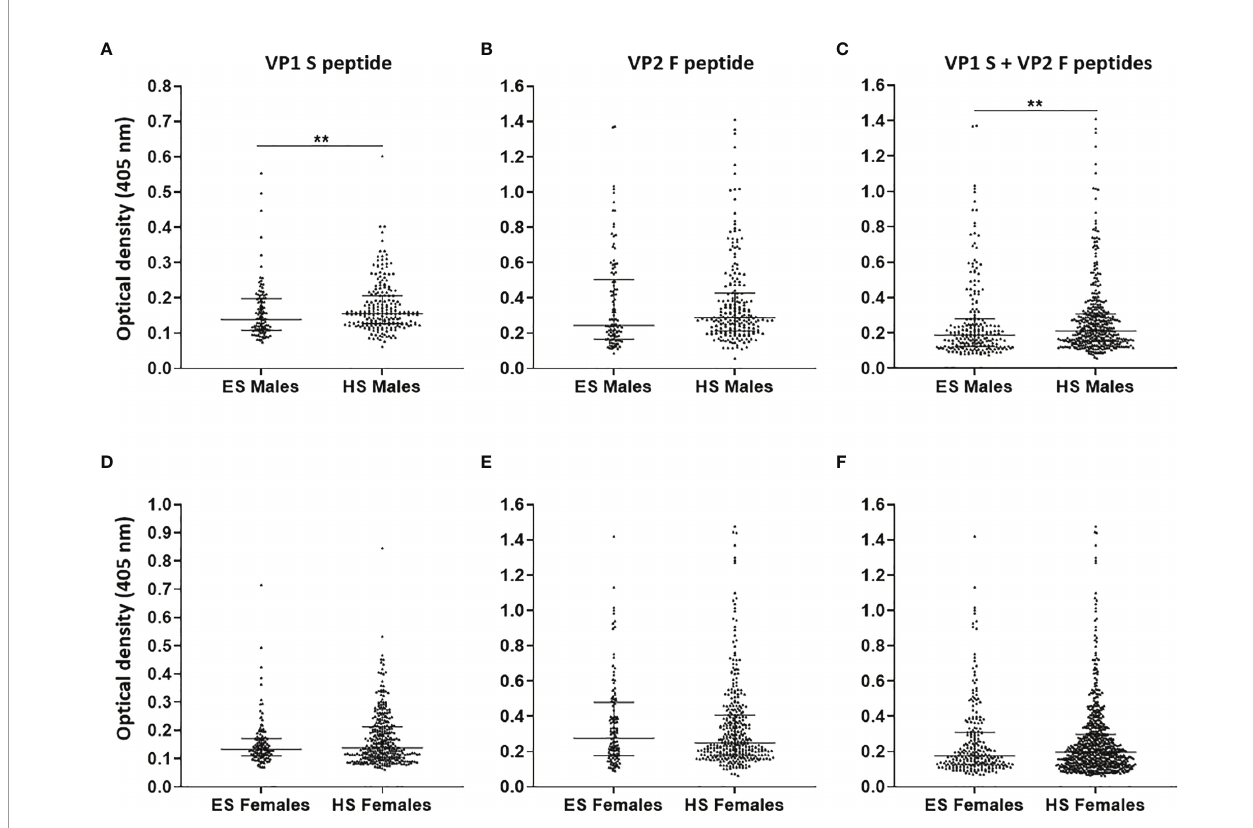
FIGURE 4 | Serologic pro fi les of serum antibody reactivity to Merkel cell polyomavirus (MCPyV) VP1 S (A, D) and VP2 F (B, E) peptides and for combined S and F peptides (C, F) evaluated in gender-strati fi ed elderly subjects (ES) compared with gender-strati fi ed healthy subjects (HS). Immunologic data are from gender-strati fi ed ES (n = 106 males and n = 120 females) and HS (n = 210 males and n = 338 females). Results are expressed as optical density (OD) value readings at l 405nm for serum samples assayed in indirect ELISA. In the scatter dot plot, each dot represents the dispersion of ODs for each sample. The median is indicated by the line inside the scatter plot with the interquartile range (IQR) for each group of subjects analyzed. (A) **p < 0.01; (C) **p <